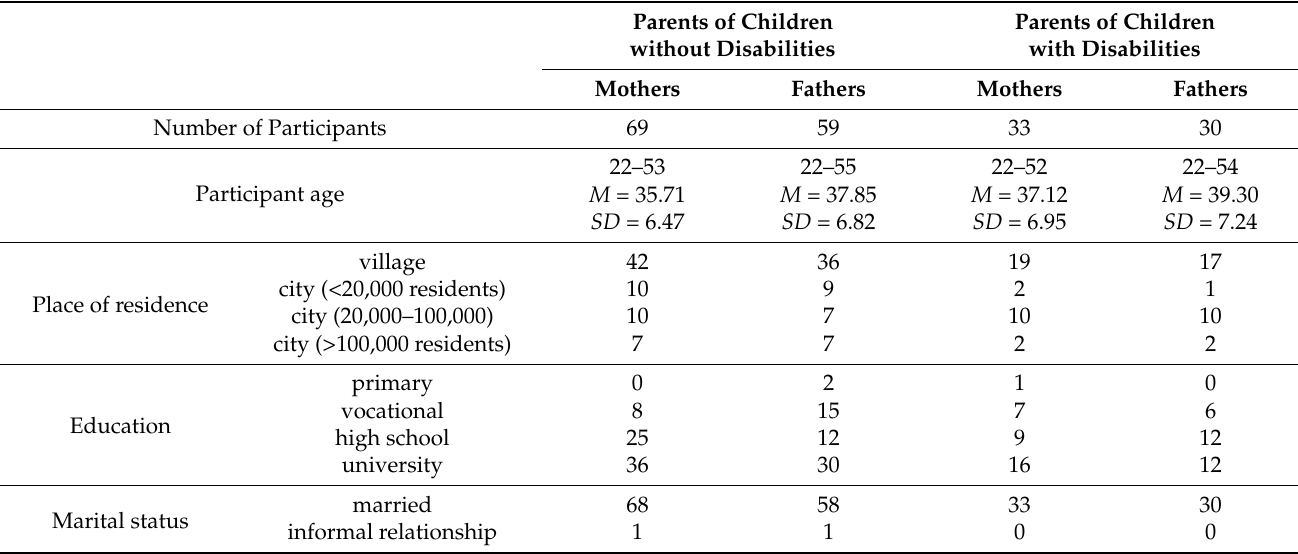
Table 1. Characteristics of the participants ( n